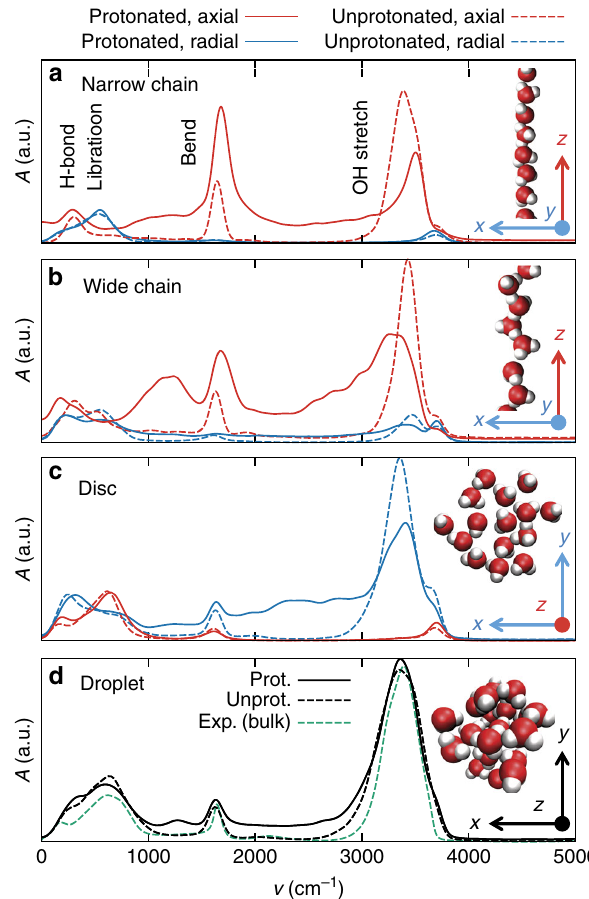
Fig. 1 Simulated spectra and snapshots. Anisotropic infrared spectra computed from ab initio trajectories for a a narrow chain, b a wide chain, c a disc, and d a droplet of water with (solid lines) and without (dashed lines) an excess proton. Red lines show the spectrum for an E fi eld in the axial z direction, blue lines the spectrum for an E fi eld in the radial xy directions, where radial components are averaged. For the droplet, all directions are averaged. In d , the experimental bulk water absorption spectrum at T = 25 ° C 31 is included (green dashed line). In each panel, the intensities of the computed spectra are drawn to